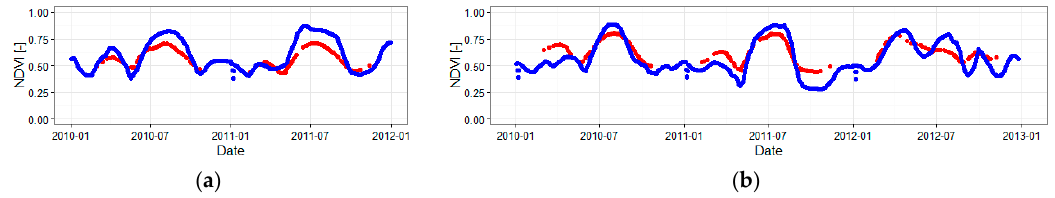
Figure A2. Comparison between 1 km NDVI (red line) and 250 m (blue line) in Landriano ( a ) and Livraga ( b ).